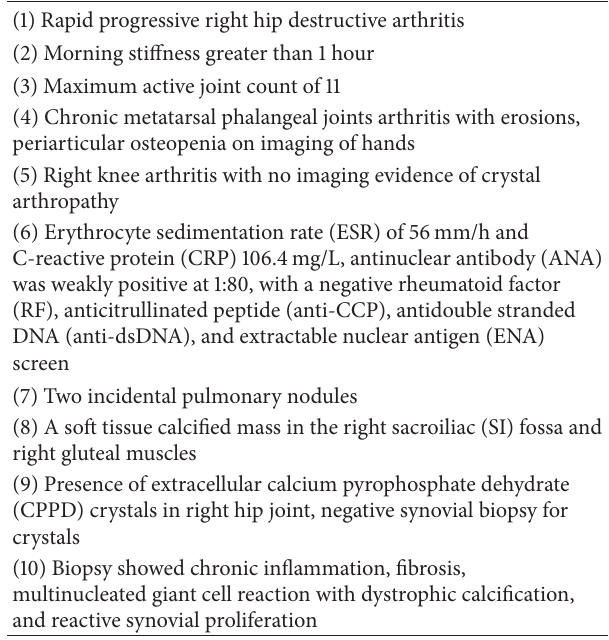
Table 1: Major clinical, lab, and imaging